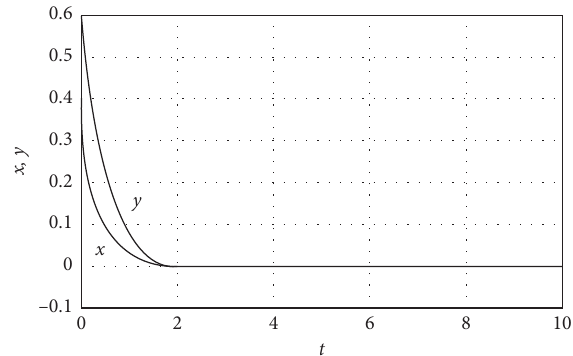
Figure 3: Dynamic evolution of government and enterprise strategy ( c ).